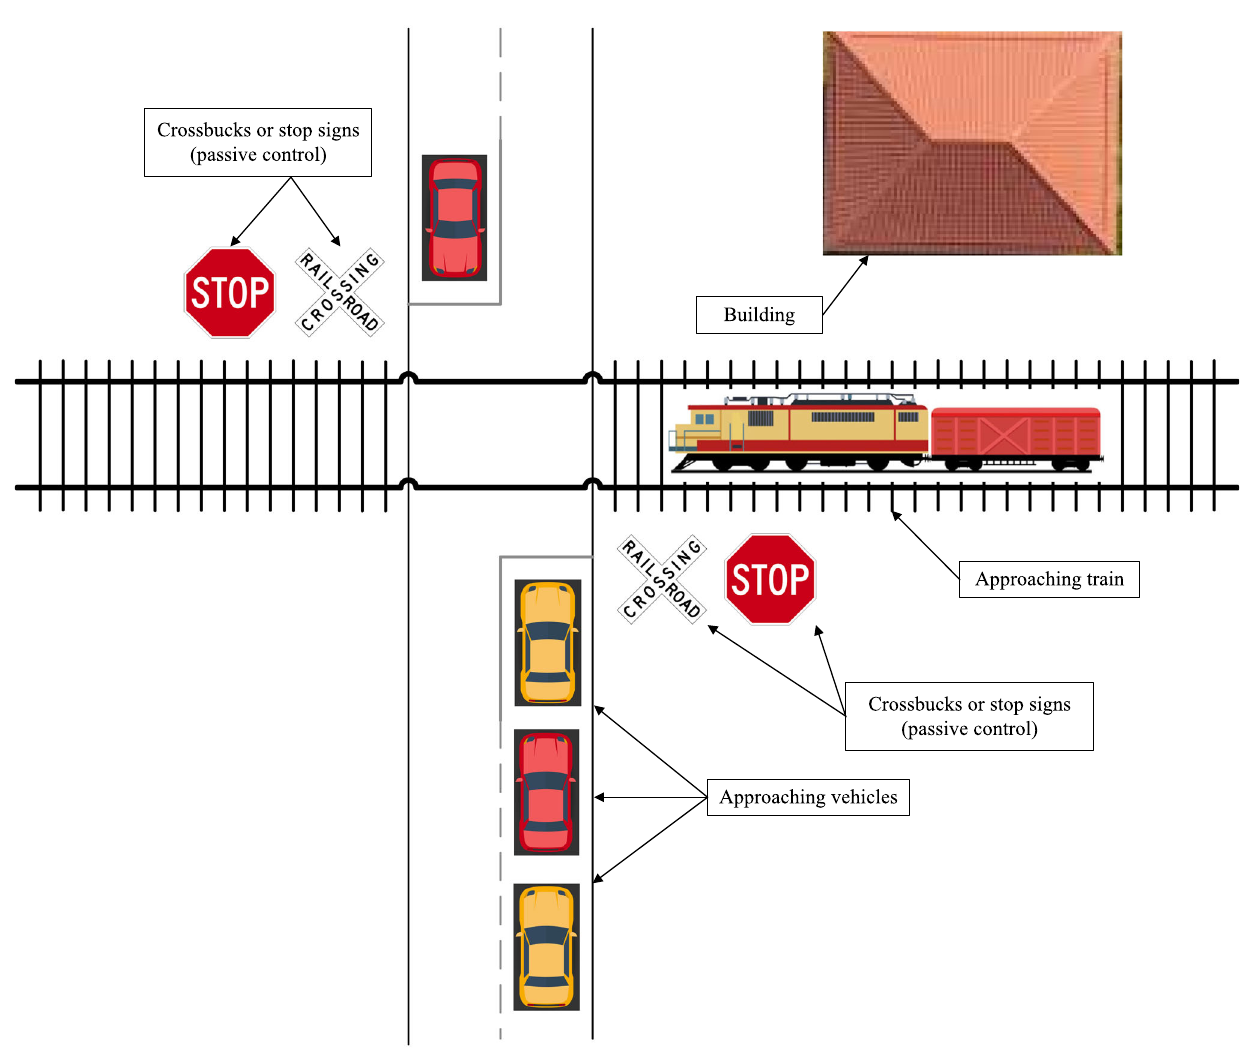
Fig. 1 A schematic illustration of an